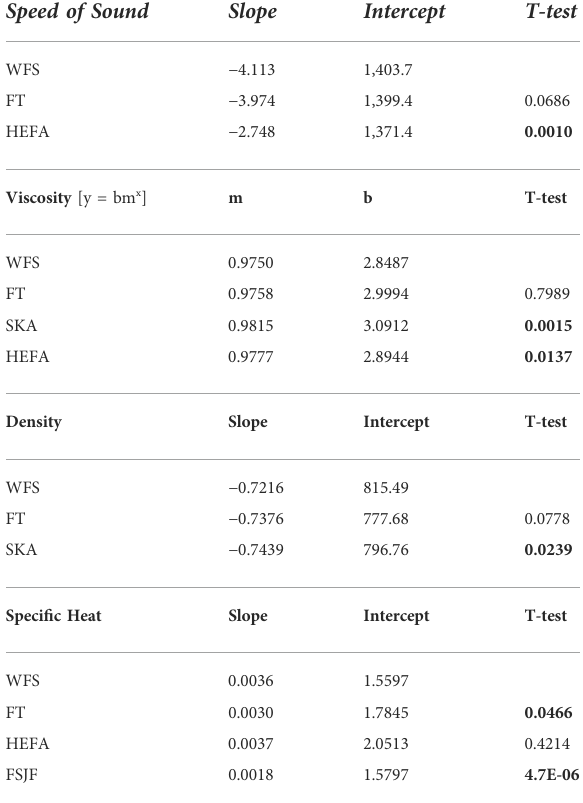
TABLE 6 Statistical analysis results for slope variability for thermophysical property relations for SAF. Speed of Sound